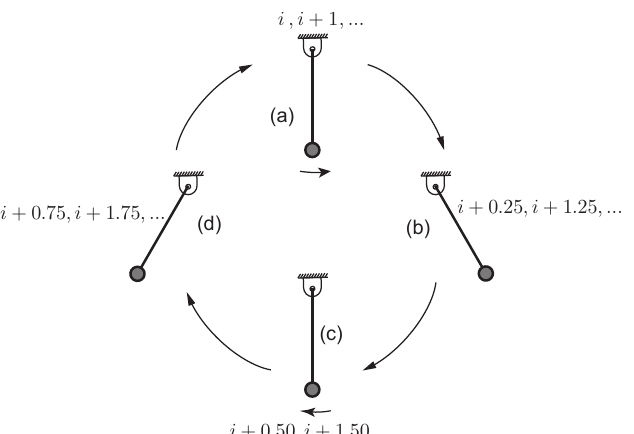
Figure 3. A single swing of a simple pendulum. The pendulum’s motion may be divided into four distinct instants. ( a ) Instant i , i + 1, . . ., the pendulum is in the vertically downward position with angular velocity in the counter-clockwise direction, ˙ θ i , ˙ θ i + 1 , ( b ) instant i + 0.25, i + 1.25, . . ., the pendulum is in the extreme position θ i + 0.25 , θ i + 1.25 , . . ., ( c ) instant i + 0.5, i + 1.5, . . ., the pendulum is in the vertically downward position with angular velocity in the clockwise direction, ˙ θ i + 0.5 , ˙ θ i + 1.5 , and ( d ) instant i + 0.75, i + 1.75, . . ., the pendulum is in the extreme position θ i + 0.75 , θ i + 1.75 , . .